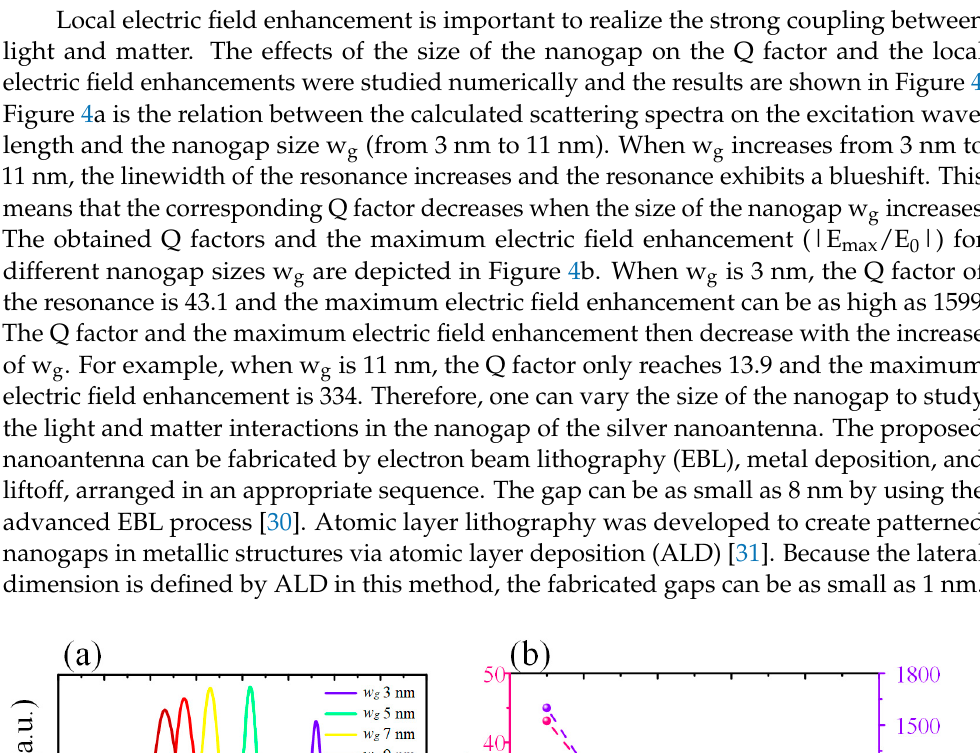
Figure 3. ( a ) The electric field distribution of the longitudinal mode on the plane z = 0 for the silver nanoantenna directly placed on the silica substrate. ( b ) The electric field distribution of the longi- tudinal mode on the plane x = 0 for the silver nanoantenna directly placed on the silica substrate. The color bars indicate the electric field enhancement.